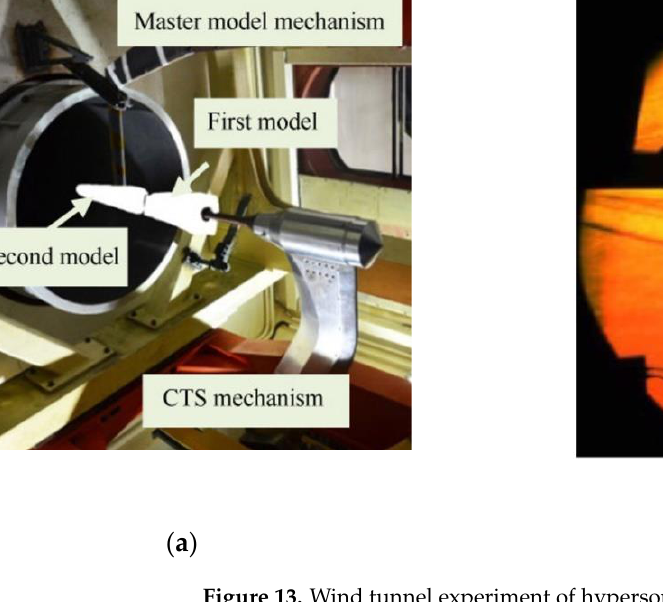
Figure 13. Wind tunnel experiment of hypersonic stage separation: ( a ) model and mechanism in the wind tunnel; ( b ) Schlieren images of wind tunnel experiment [44]. Table 5. Free-stream flow conditions of stage